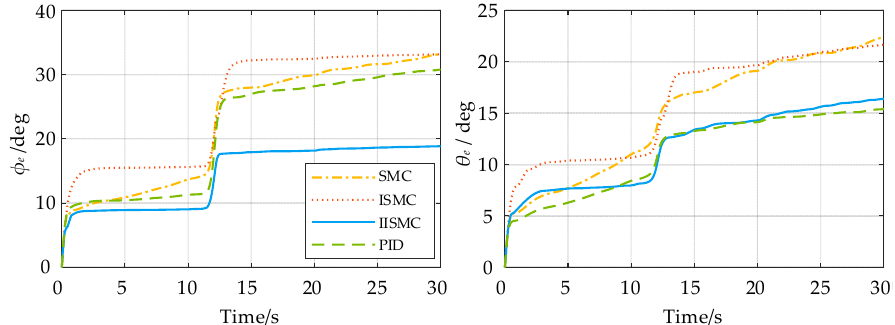
Figure 14. Cumulative attitude angles error under four control methods in Scene 3.